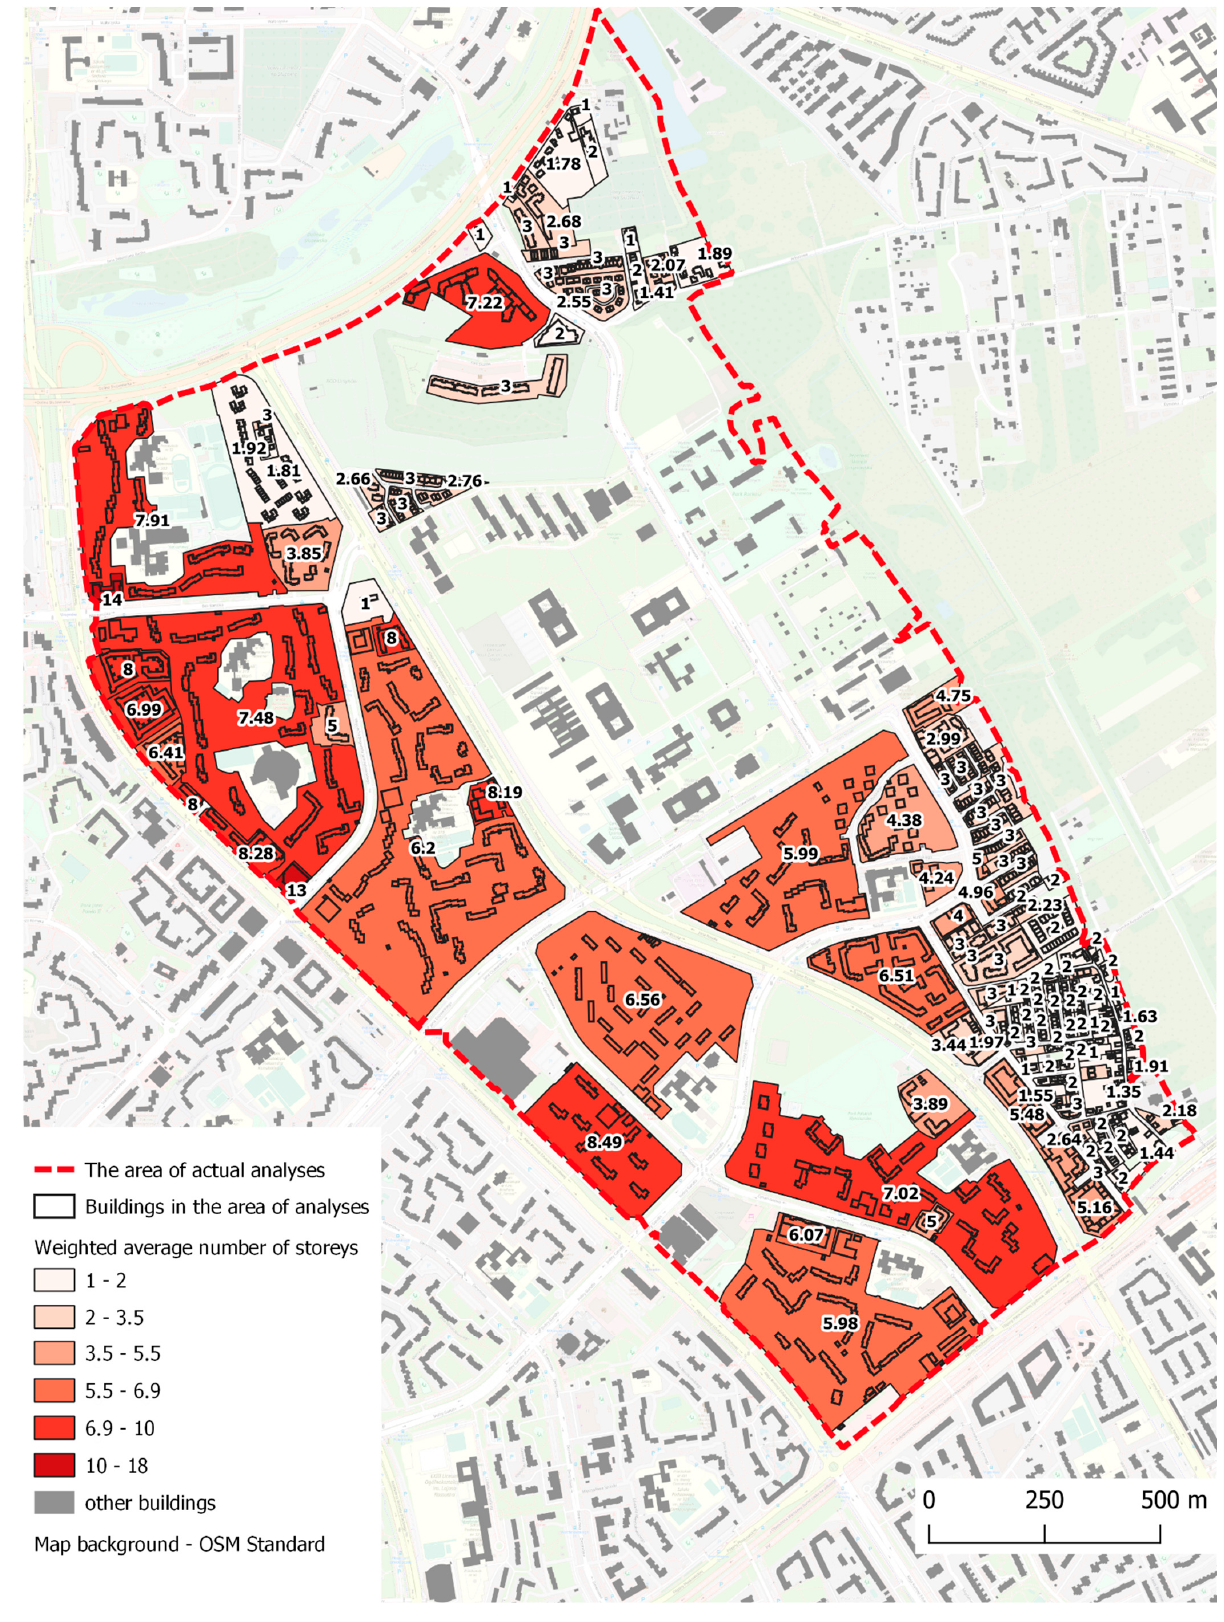
Figure A3. Weighted average number of storeys-SWLK.